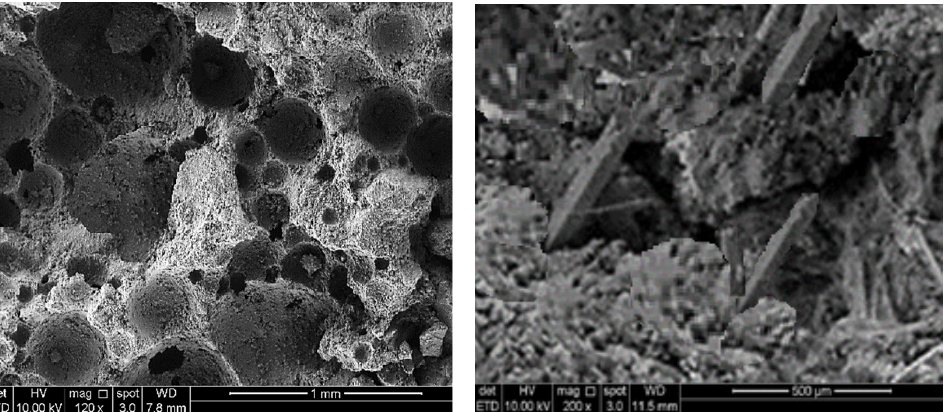
Figure 9. Morphology of plain LFC ( left ) and MNP-LFC composites ( right ).